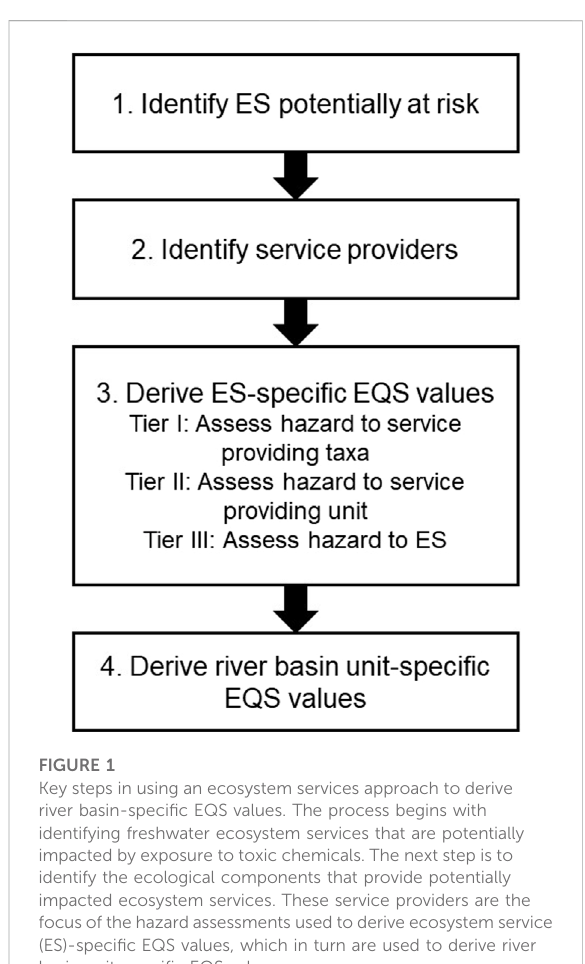
FIGURE 1 Key steps in using an ecosystem services approach to derive river basin-speci fi c EQS values. The process begins with identifying freshwater ecosystem services that are potentially impacted by exposure to toxic chemicals. The next step is to identify the ecological components that provide potentially impacted ecosystem services. These service providers are the focus of the hazard assessments used to derive ecosystem service (ES)-speci fi c EQS values, which in turn are used to derive river basin unit-speci fi c EQS